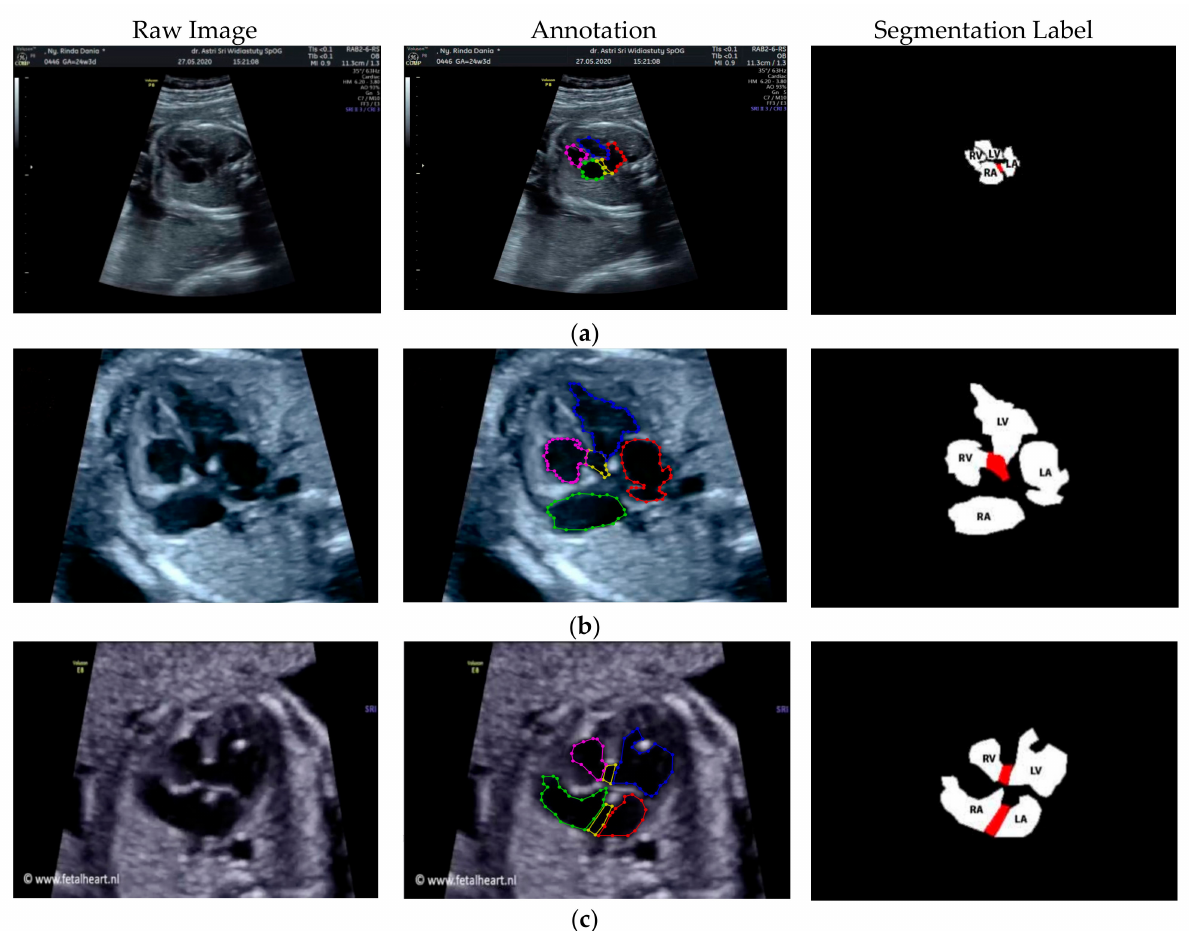
Figure 5. The sample of annotated image by maternal–fetal clinician for heart defect detection in case: ( a ) ASD; ( b ) VSD; and ( c ) AVSD. In the annotation, the green line is RA, the red line is LA, the purple line is RV, the blue line is LV, and the yellow line is defect.